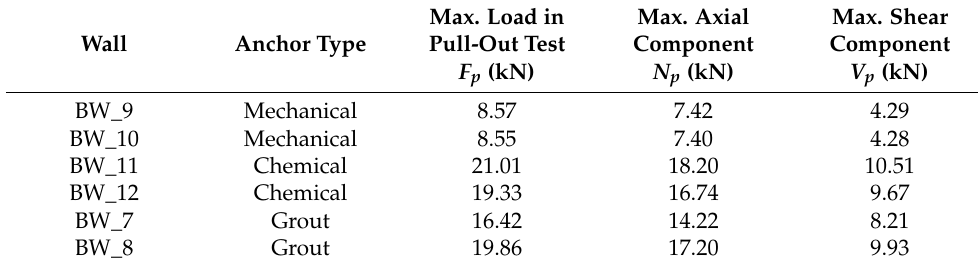
Table 6. Experimental results from pull-out test with inclined actuator.